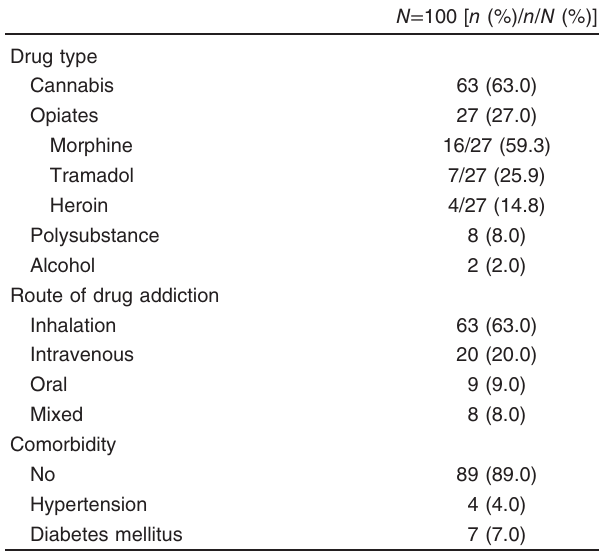
Table 1 Description of the different types of drug addiction, the route of administrations and comorbidities of the